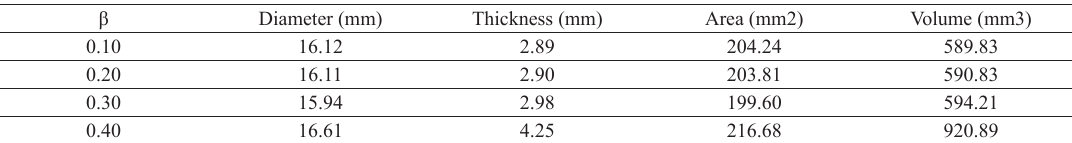
Figure 1. Pellet (a) and Toroid (b) samples. Table 4. Dimensional measurements of pellet